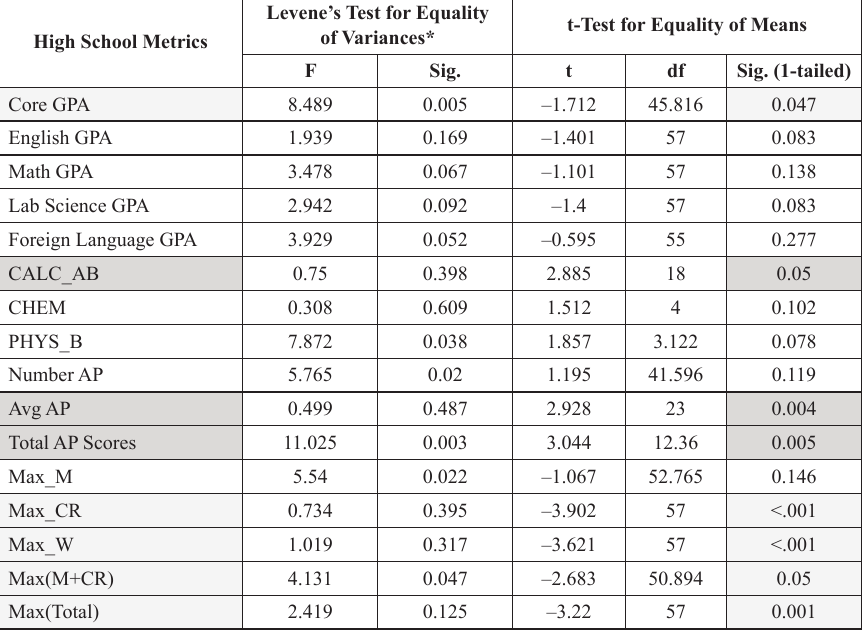
Table 6. Statistical Tests of High School Incoming Metrics between Purdue